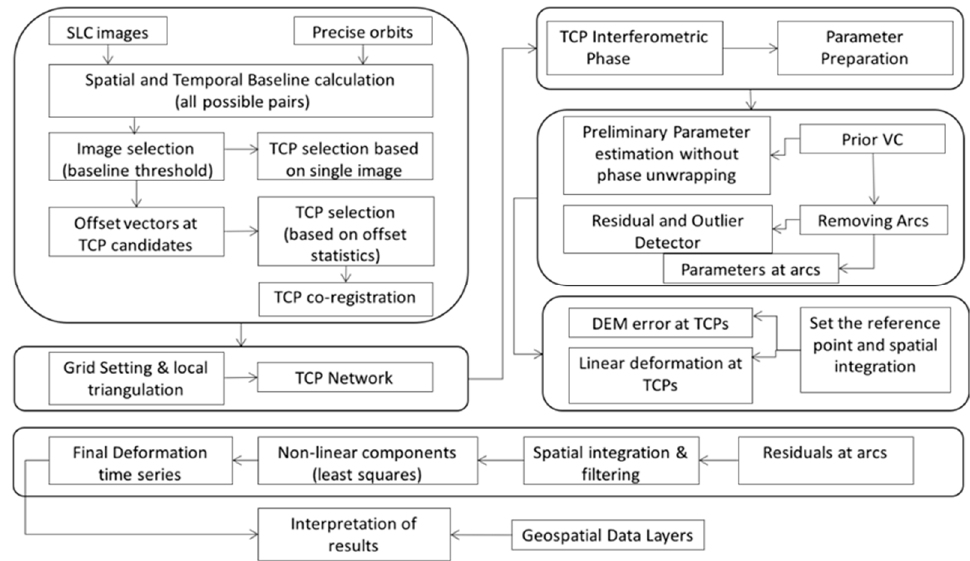
Figure 2. Flow chart of the methodology adopted in this